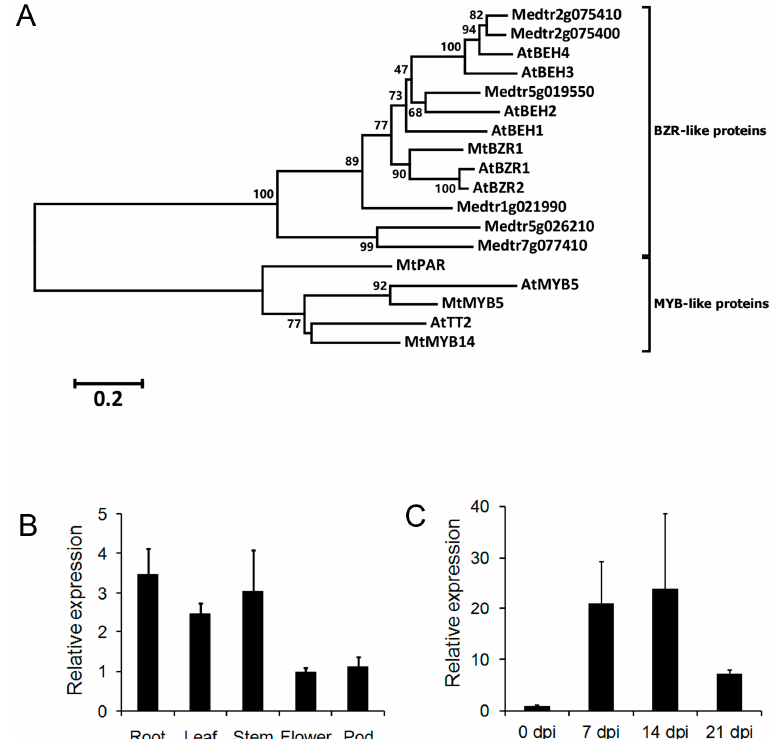
Figure 1. The phylogenetic analysis and expression of Medicago truncatula brassinazole resistant 1 ( MtBZR1 ). ( A ) A neighbor-joining tree of BRASSINAZOLE-RESISTANT 1 (BZR1)-like proteins in A. thaliana and M. truncatula . AtMYB5 and A. thaliana TRANSPARENT TESTA 2 (AtTT2) acted as an outgroup sequence. Multiple alignment and phylogenetic analysis were run with the MEGA6 program with 1000 bootstraps. Scores higher than 50 are labeled by the branches. The protein sequences from A. thaliana start with “At”; those from M. truncatula start with “Mt”. ( B ) Expression of MtBZR1 in M. truncatula tissues. The expression in the flower was set as 1.0. ( C ) Expression of MtBZR1 in nodules after inoculation with rhizobium (dpi, days post inoculation). The expression at zero dpi was set as 1.0. In ( B , C ), MtUbiquitin gene was used as an internal control. Bars represent standard errors from three biological